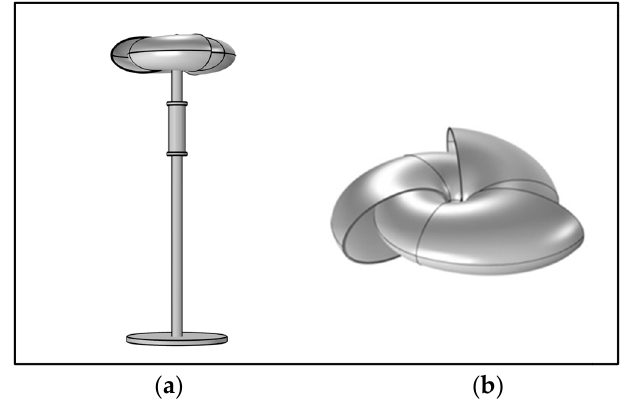
Table 1. The specific parameter of the wind turbine.